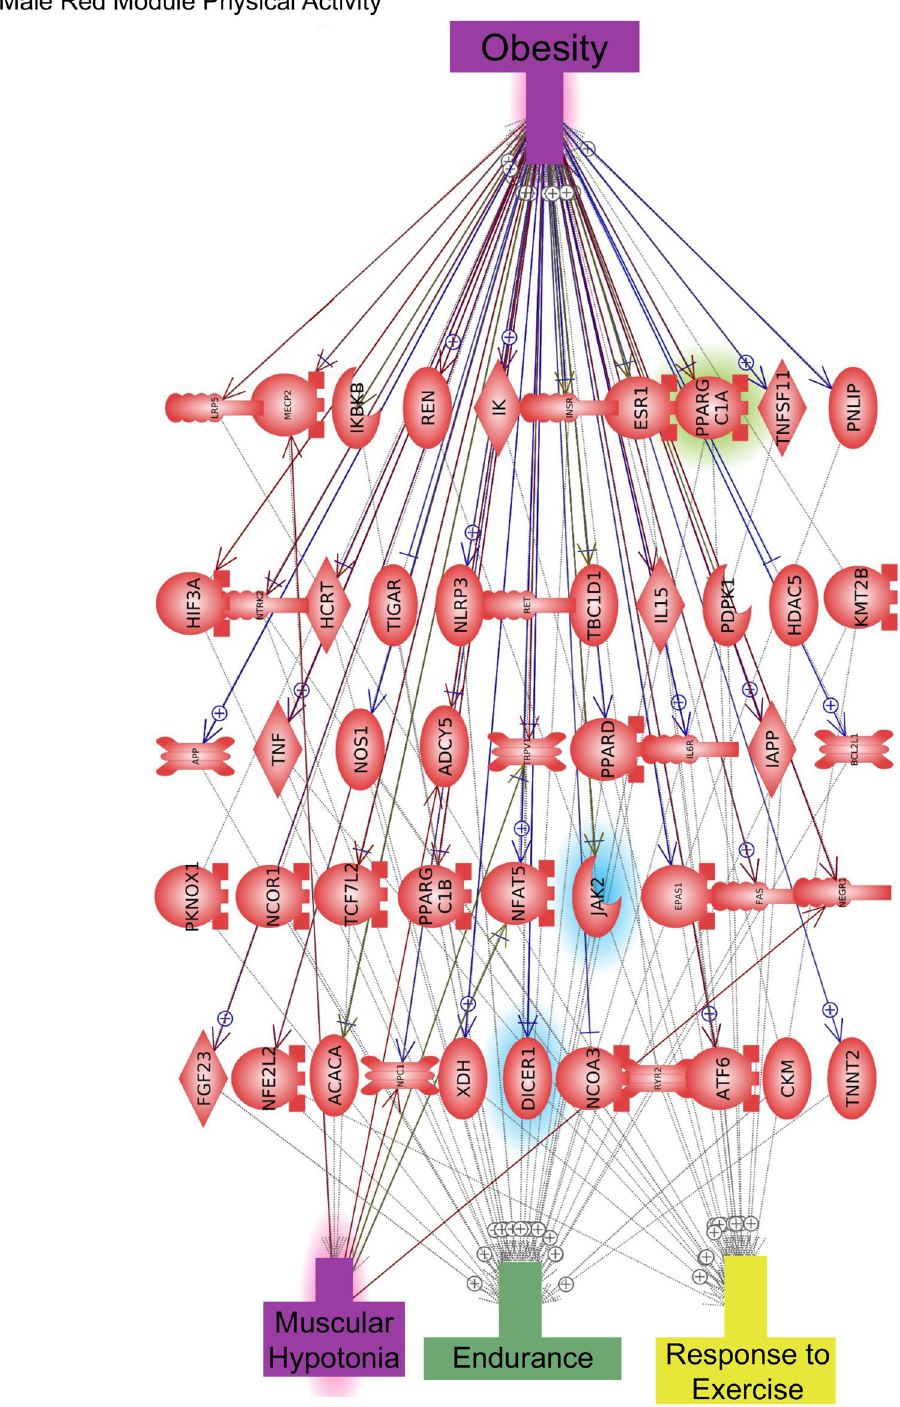
Figure 9. Male Red module-trait physical activity. Twin epigenetic site gene association network analysis. Male red module physical activity. Highlights indicate blue = activity, green = walkability, yellow = BMI, and red = significant over-representation. Gene links in common for obesity and physical activity